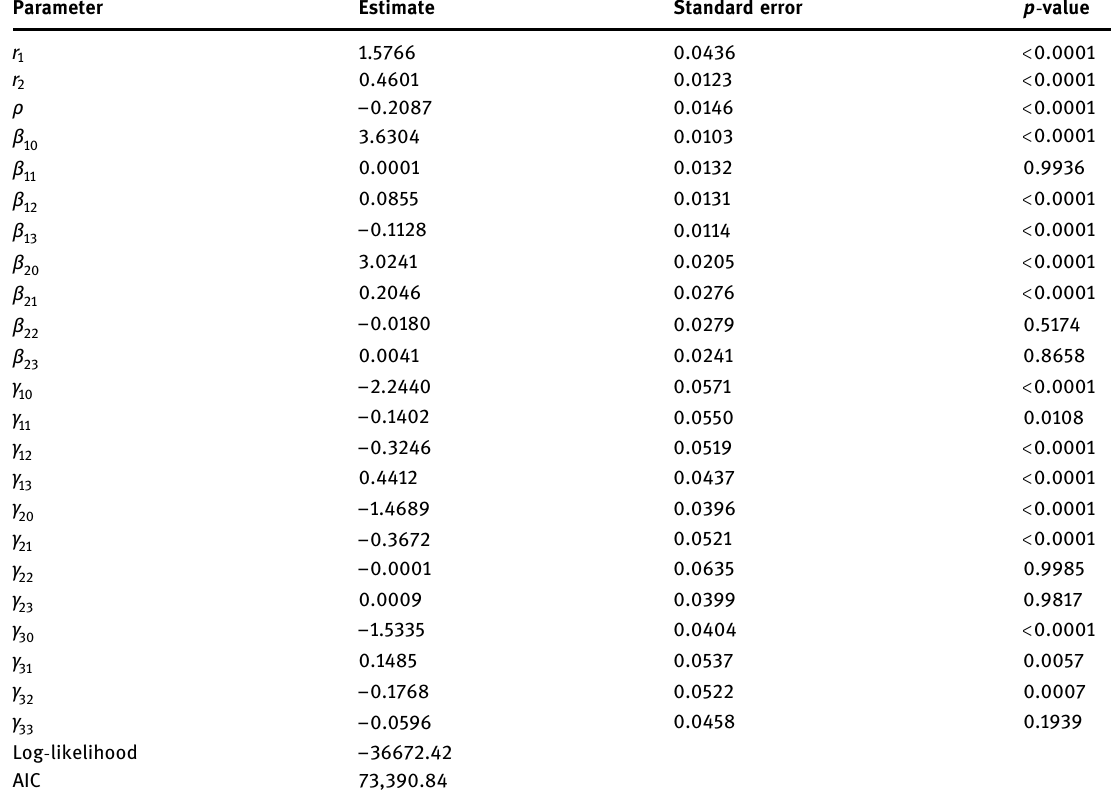
Table 7: Parameter estimates